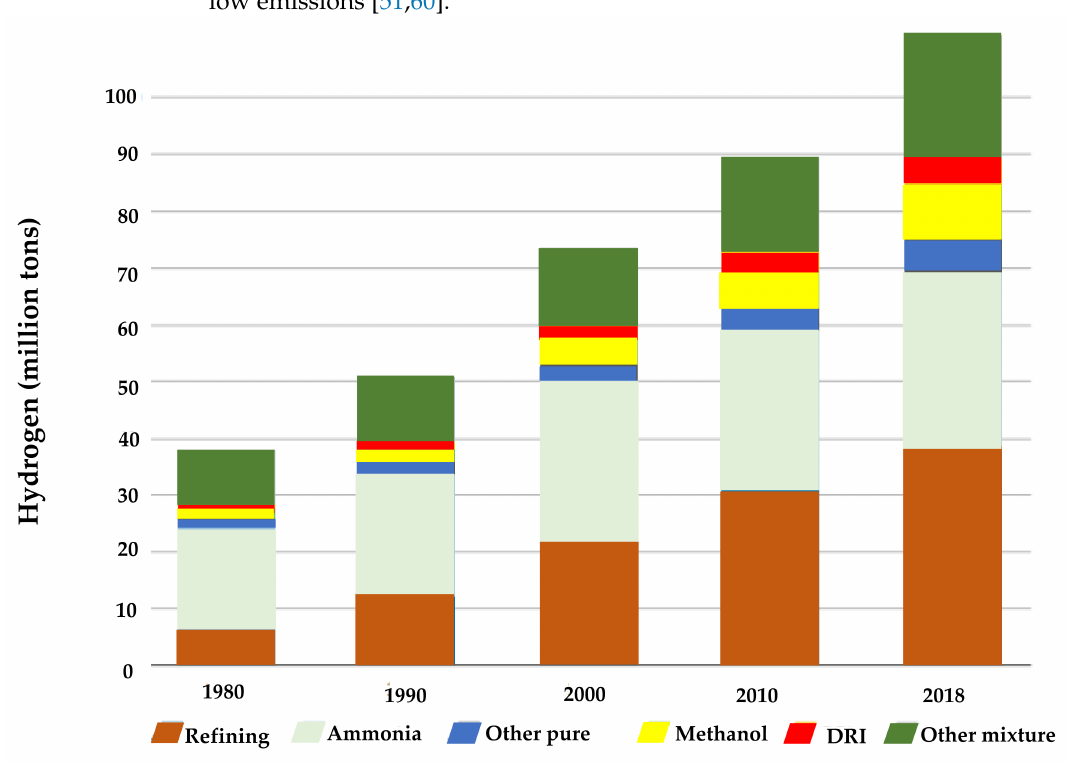
Figure 4. Hydrogen use trend in the period from 1980 to 2018. DRI: direct reduction in the steel industry. Adapted from IRENA